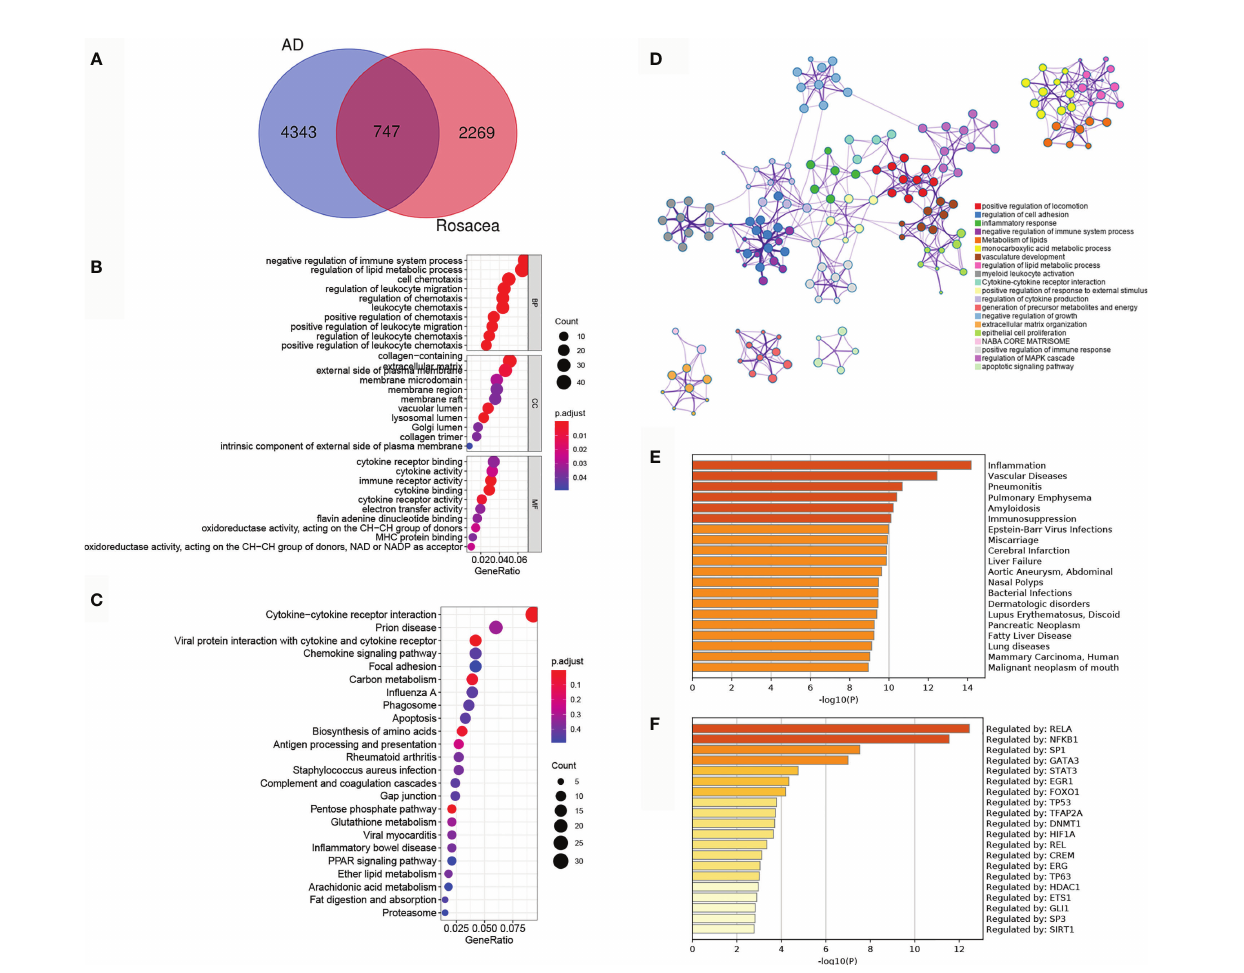
FIGURE 2 | The co-differentially expressed genes (DEGs) in Alzheimer ’ s disease (AD) and rosacea. (A) The Venn graph of ol-DEGs in both AD and rosacea. (B) GO enrichment analysis of ol-DEGs. (C) The KEGG analysis of co-DEGs. (D) The pathway enrichment analysis of co-DEGs using Metascape. (E) The disease enrichment analysis of ol-DEGs in DisGeNET using Metascape. (F) The transcription factor (TF) enrichment analysis of ol-DEGs in TRRUST using